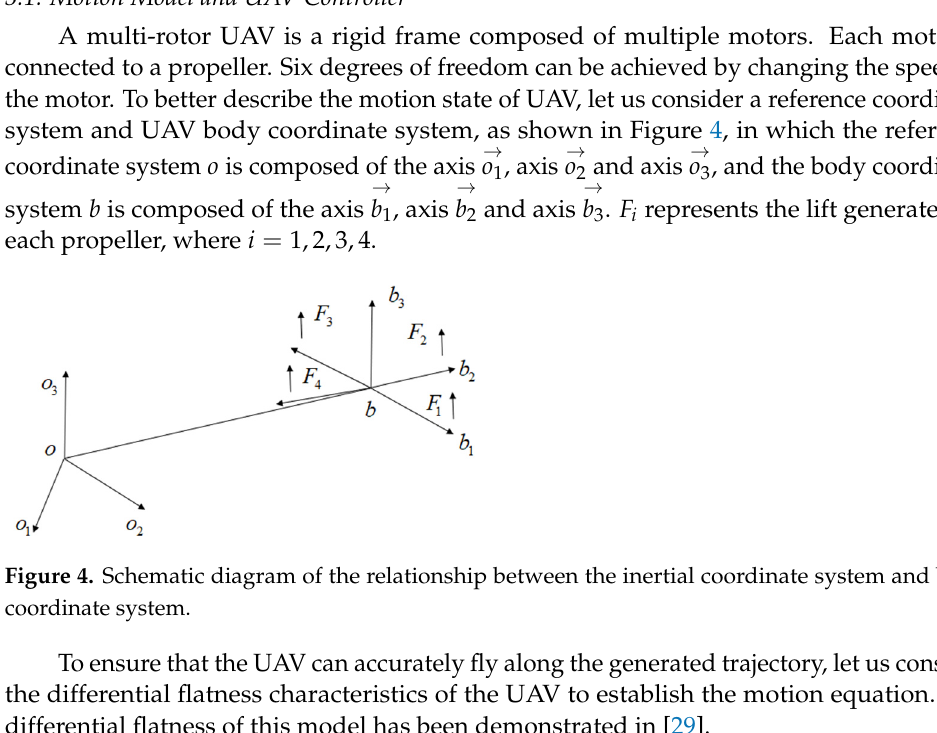
Figure 3. Schematic diagram of the camera model and parameters.